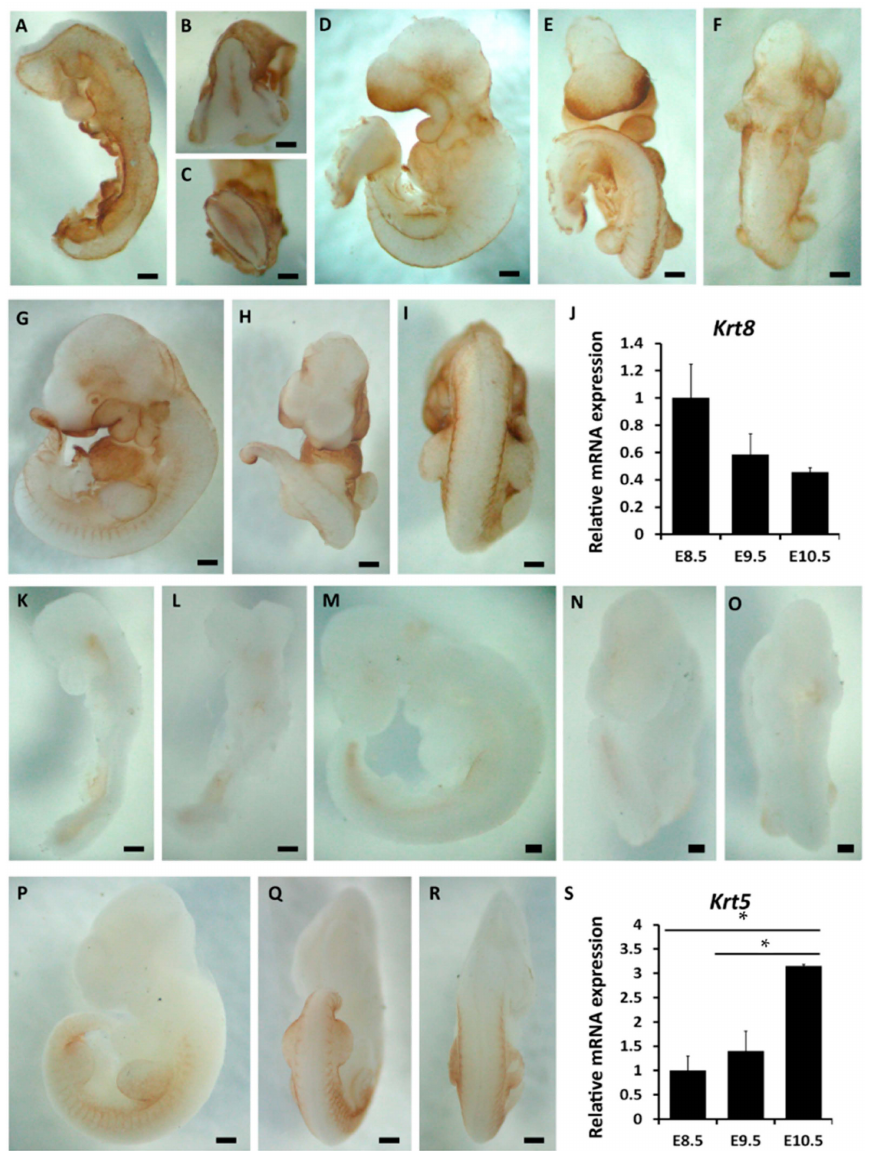
Figure 1. The spatiotemporal expression of markers related to epidermal commitment from E8.5 to E10.5 by whole-mount immunohistochemistry. ( A – I ) Whole-mount immunostaining of K8 in mouse embryos at E8.5 (( A ) lateral; ( B ) cephalic; ( C ) caudal view), E9.5 (( D ) lateral; ( E ) ventral; ( F ) dorsal view) and E10.5 (( G ) lateral; ( H ) ventral; ( I ) dorsal view); ( J ) qRT-PCR result showing Krt8 mRNA expression at different embryonic days during epidermal commitment; ( K – R ) Whole-mount immunostaining of K5 in mouse embryos at E8.5 (( K ) lateral; ( L ) ventral side), E9.5 (( M ) lateral; ( N ) ventral; ( O ) dorsal view), E10.5 (( P ) lateral; ( Q ) ventral; ( R ) dorsal view); ( S ) qRT-PCR result showing Krt5 mRNA expression at different embryonic days during epidermal commitment. Bar = 200 µ m for ( A – F ) and ( K – O ); bar = 500 µ m for G – I and ( P – R ). * p < 0.05.